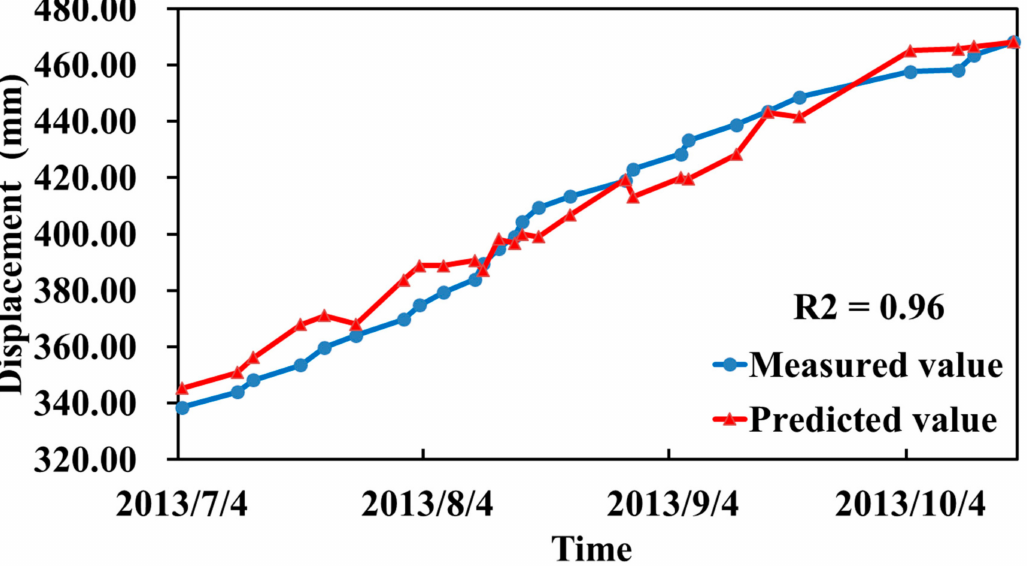
Figure 11. Measured and predicted process lines and the goodness of fit, R 2